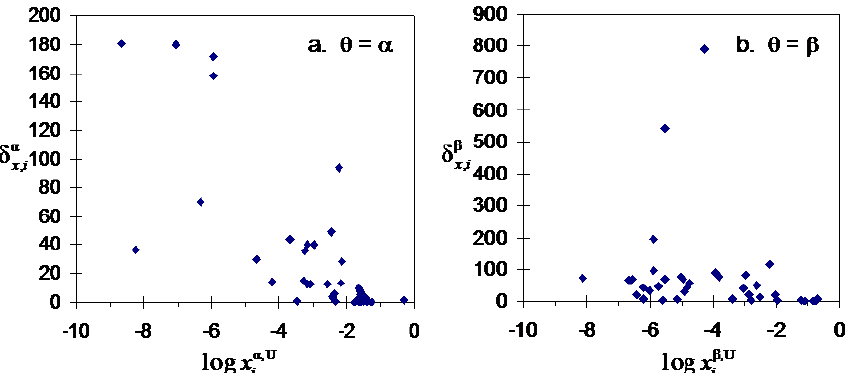
Fig. 3. Unsigned percentage difference between the values of x θ (U=UNIFAC) for θ = α and for θ = β in the performance evaluation (PE) case.